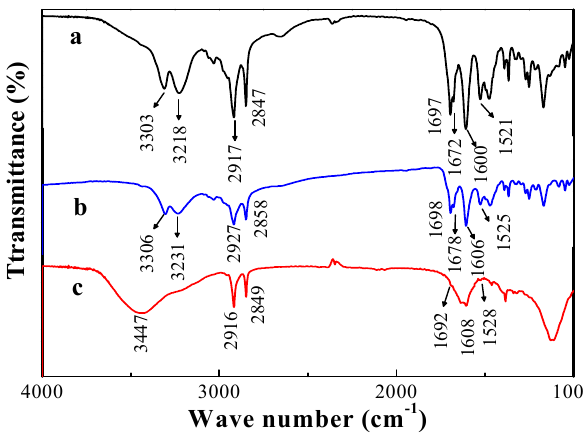
Figure 4. FTIR spectra of compound 4: ( a ) xerogel, ( b ) gel in CCl 4 (4.0 wt%), and ( c ) solution in CCl 4 (0.1 wt%).